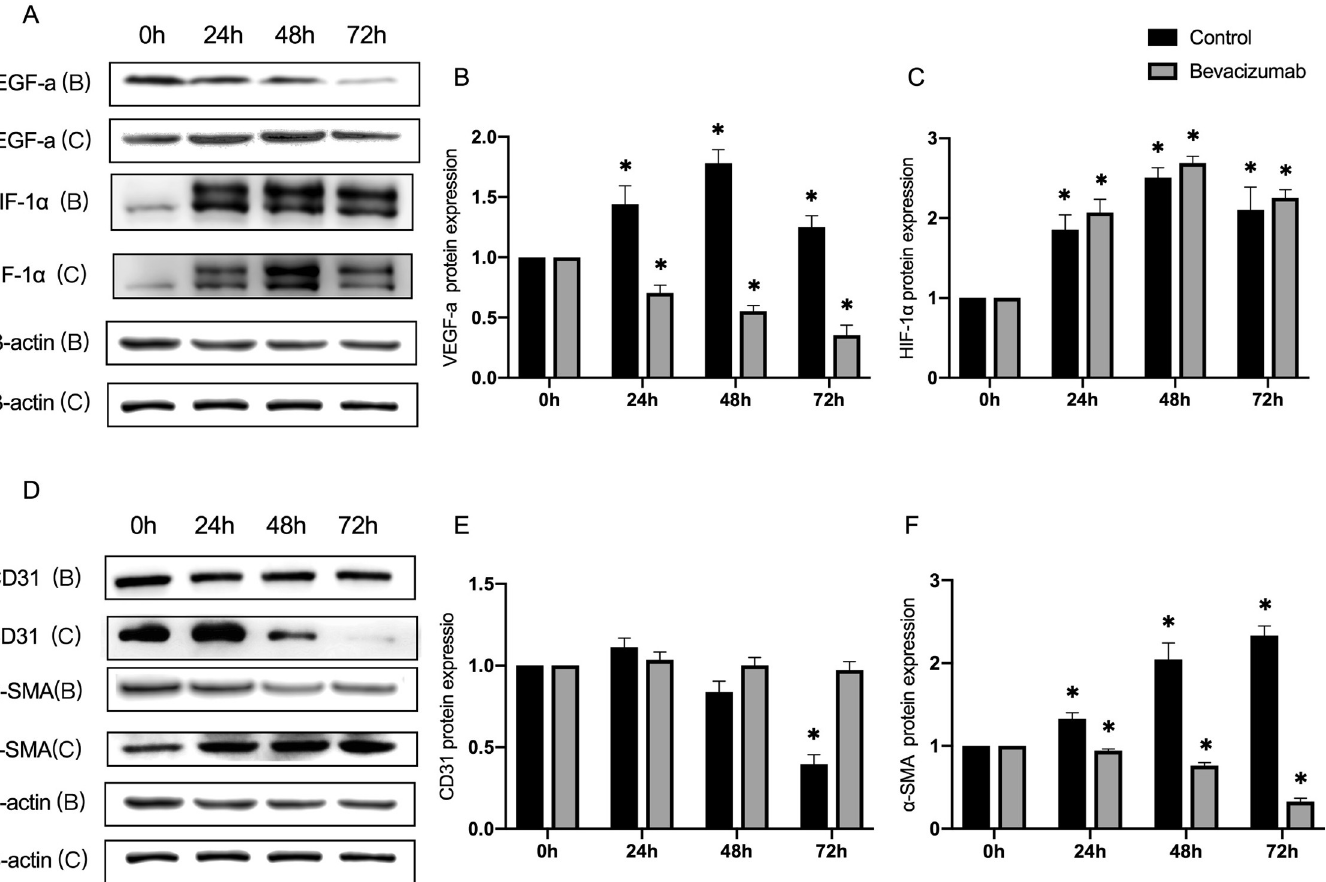
Fig 6. The hypoxia-treated ECs were incubated with bevacizumab, the VEGF-a inhibitor, and the expression of VEGF-a, HIF-1 α , CD31 and α -SMA were detected. (A and D) Representative images from the western blot performed for the detection of VEGF-a, HIF-1 α , CD31 and α -SMA, with and without bevacizumab treatment. (B, C, E and F) Densitometric analyses of the western blot experiments. The above experiments were repeated three times independently. The statistical differences were assessed by one-way analysis of variance (ANOVA) (Kruskal–Wallis), followed by Dunn’s posthoc test. � P < 0.05 against the untreated condition. The graph bars show the mean ± SD. The asterisk on top of the bars correlate to the 24, 48 and 72 hours, which represent the comparison with the bars at zero